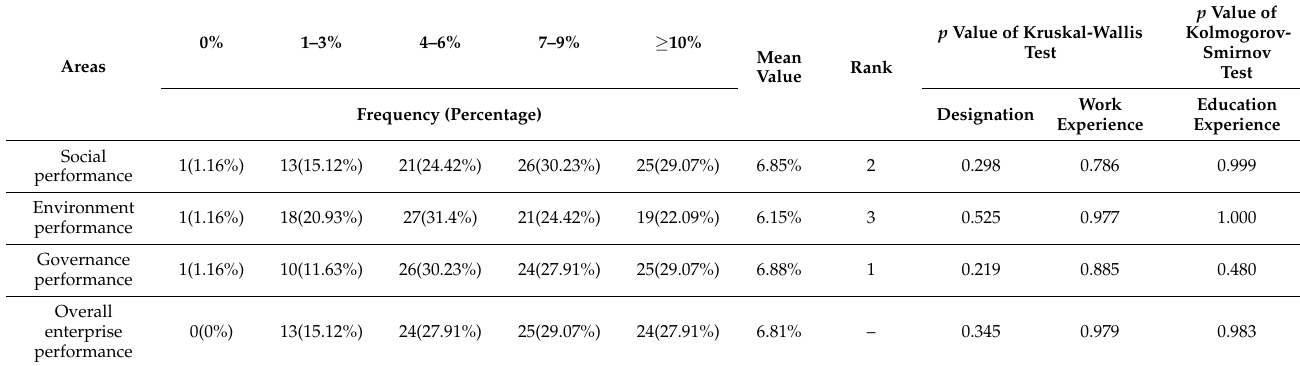
Table 9. Perceived enterprise performance